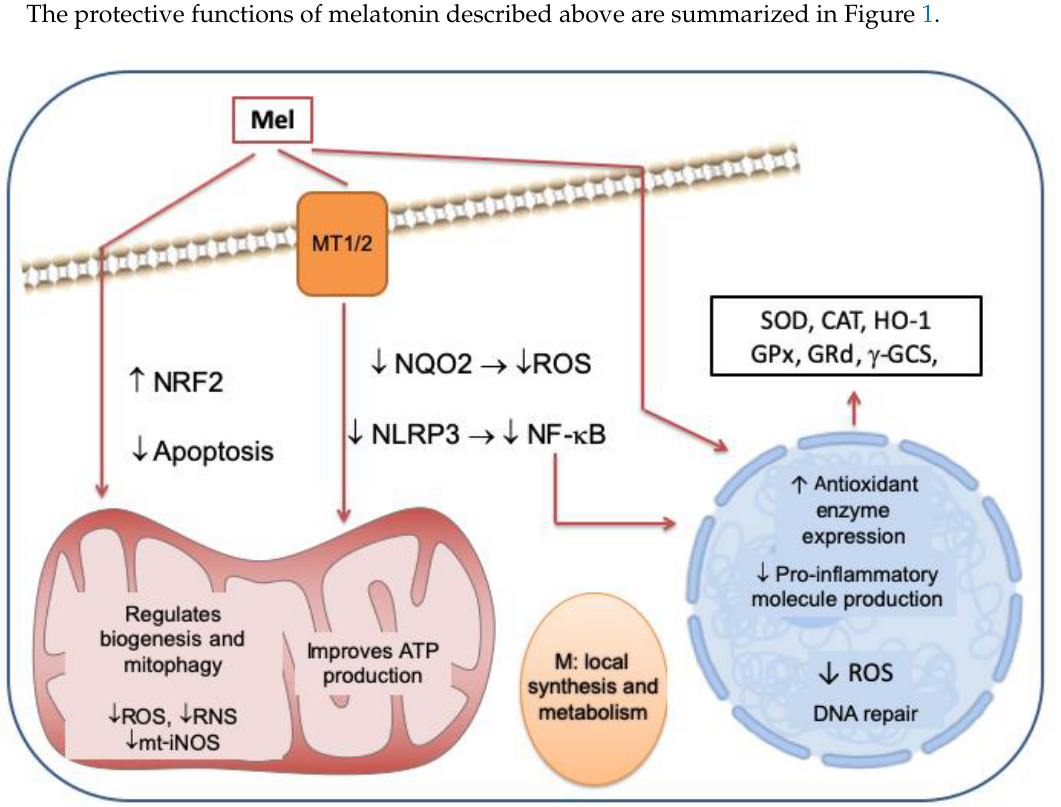
Figure 1. Melatonin crosses cell membranes and acts through membrane (MT1/2) and nuclear (ROR) receptors in order to reach different cellular organelles including mitochondria and nuclei. Melatonin’s antioxidant properties are characterized by its capacity to stimulate the production of antioxidant enzymes such as superoxide dismutase (SOD), catalase (CAT), heme oxygenase-1 (HO- 1), glutathione peroxidase (GPx), glutathione reductase (GRd), and -glutamyl-cystein synthase ( -GCS). Its antioxidant and cytoprotective properties are boosted by its ability to induce the expression of NRF2 and to bind and inhibit reactive oxygen species (ROS) through NQO2 in the cytosol. Melatonin can also inhibit NLRP3 inflammasome and reduce NF- B expression, leading to a reduction in proinflammatory molecules. Melatonin ameliorates DNA damage induced by external factors and has an antiapoptotic effect. At the mitochondrial level, it directly scavenges ROS and inhibits m-iNOS expression, which neutralizes both reactive oxygen and nitrogen species (ROS/RNS) in mitochondria, which improves oxidative phosphorylation and ATP production. Melatonin is synthesized and metabolized in mitochondria (M) and also plays an active role in mitochondrial homeostasis by regulating biogenesis and mitophagy. Therefore, it plays a major role in protecting the skin against damage caused by external factors. 5. Functions of Melatonin in the Skin 5.1. Melatonin as a Photoprotector Although UV has beneficial effects on human skin by increasing vitamin D and endorphins, excessive exposure entails serious health risks including erythema, atrophy, pigmentary changes, wrinkling, and malignancy. Photodamage can lead to the development of photoaging and cancer in chronically exposed skin [59]. UVR, along with visible light and infra-red rays, is one of the constituents of the solar spectrum. Ultraviolet A (UVA) radiation penetrates deeply into the dermis, while UVB penetrates the epidermis, with little reaching the dermis [60]. However, UVC has difficulty penetrating the atmosphere and can reach the upper layer of the epidermis (Figure 2). When the skin is exposed to